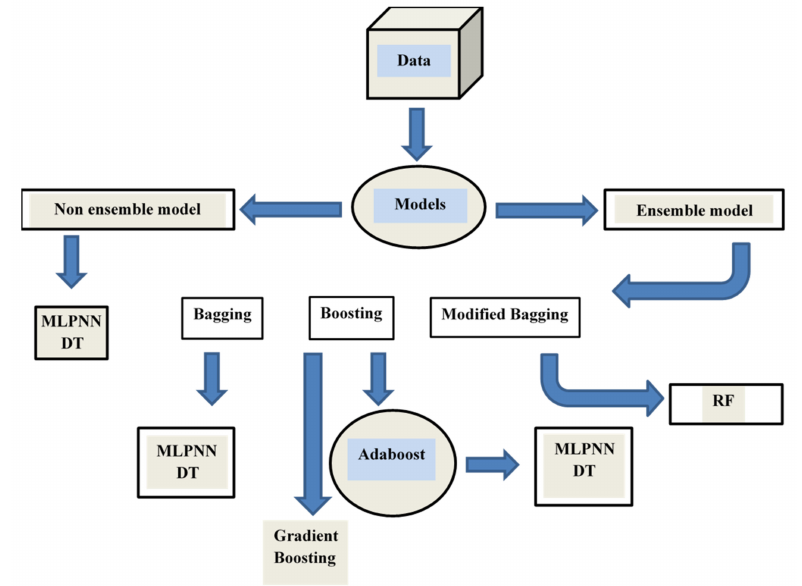
Figure 4. Flowchart of the methodology of machine